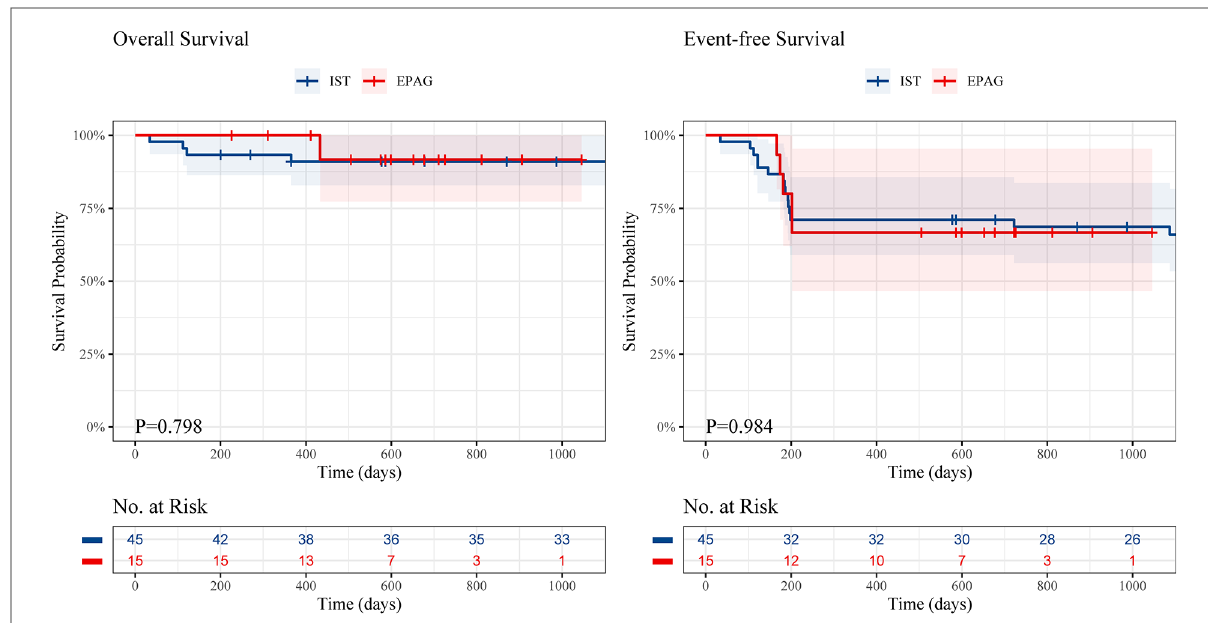
FIGURE 2 The overall survival and event-free survival of children in the EPAG and IST group. EPAG, eltrombopag; IST, immunosuppressive